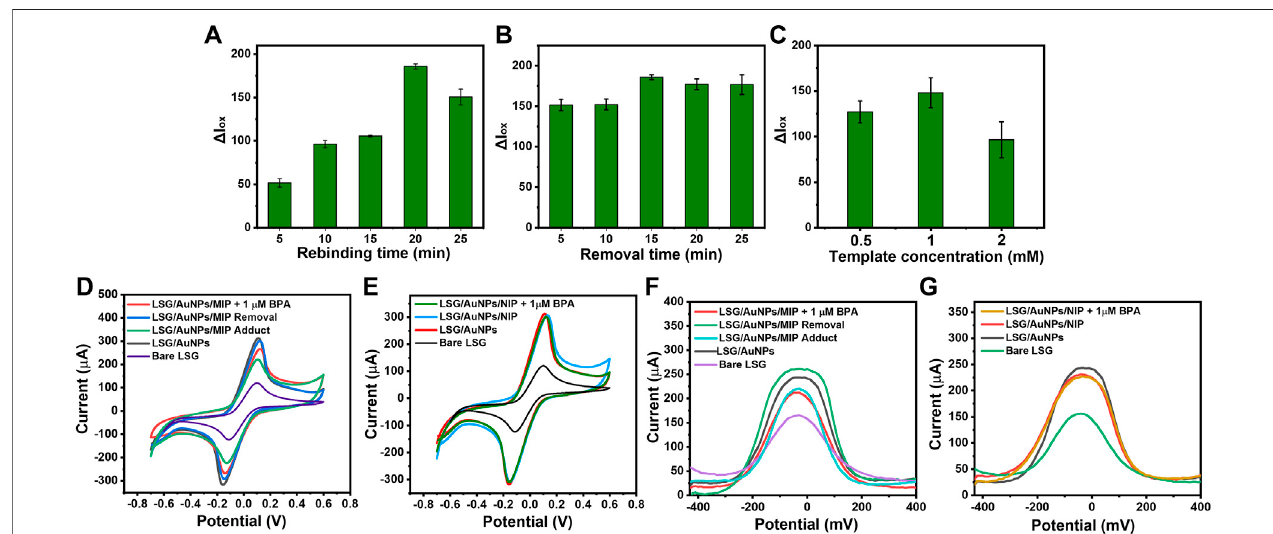
FIGURE 4 | Histograms showing the oxidation current difference before and after rebinding BPA ( Δ Iox) obtained from differential pulse voltammetries (DPVs) of LSG-MIPfor (A) rebindingtimeoptimizationafterbinding1 µMBPAofdifferentrebindingtimes, (B) removaltimeoptimizationusing20-minrebindingtimefor1 µMBPA, (C) template concentration optimization using 15 min of removal time and 20 min of rebinding time for 1 µM BPA. Cyclic voltammetries (CVs) of (D) LSG-MIP and (E) LSG-NIP in a solution of 5 mM [Fe(CN) 6 ] 3 − /4 − with 0.1 M KCl (scan rate: 100 mV/s) performed by Palmsens showing the oxidation response of bare LSG, LSG/ AuNP, before and after rebinding of 1 µM BPA. DPVs of (D) LSG-MIP and (E) LSG-NIP in a solution of 5 mM [Fe(CN) 6 ] 3 − /4 − with 0.1 M KCl performed by KAUSTat showing the oxidation response of bare LSG, AuNPs/LSG, before and after rebinding of 1 µM BPA.